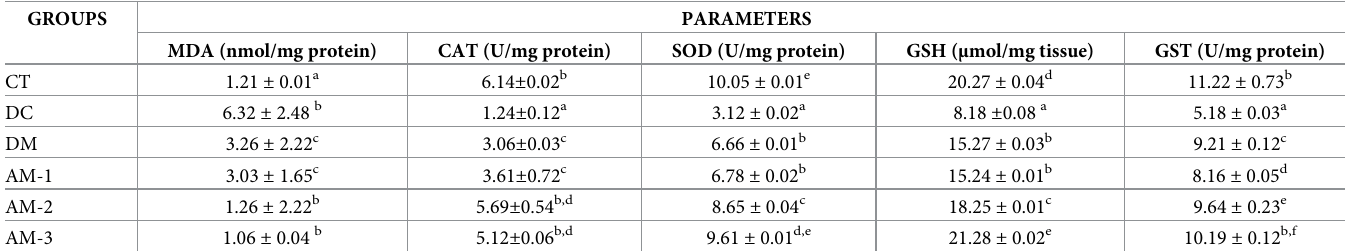
Table 6. Hepatic antioxidant markers of alloxan-induced diabetic rats after oral administration of aqueous extract of A . muricata peels.